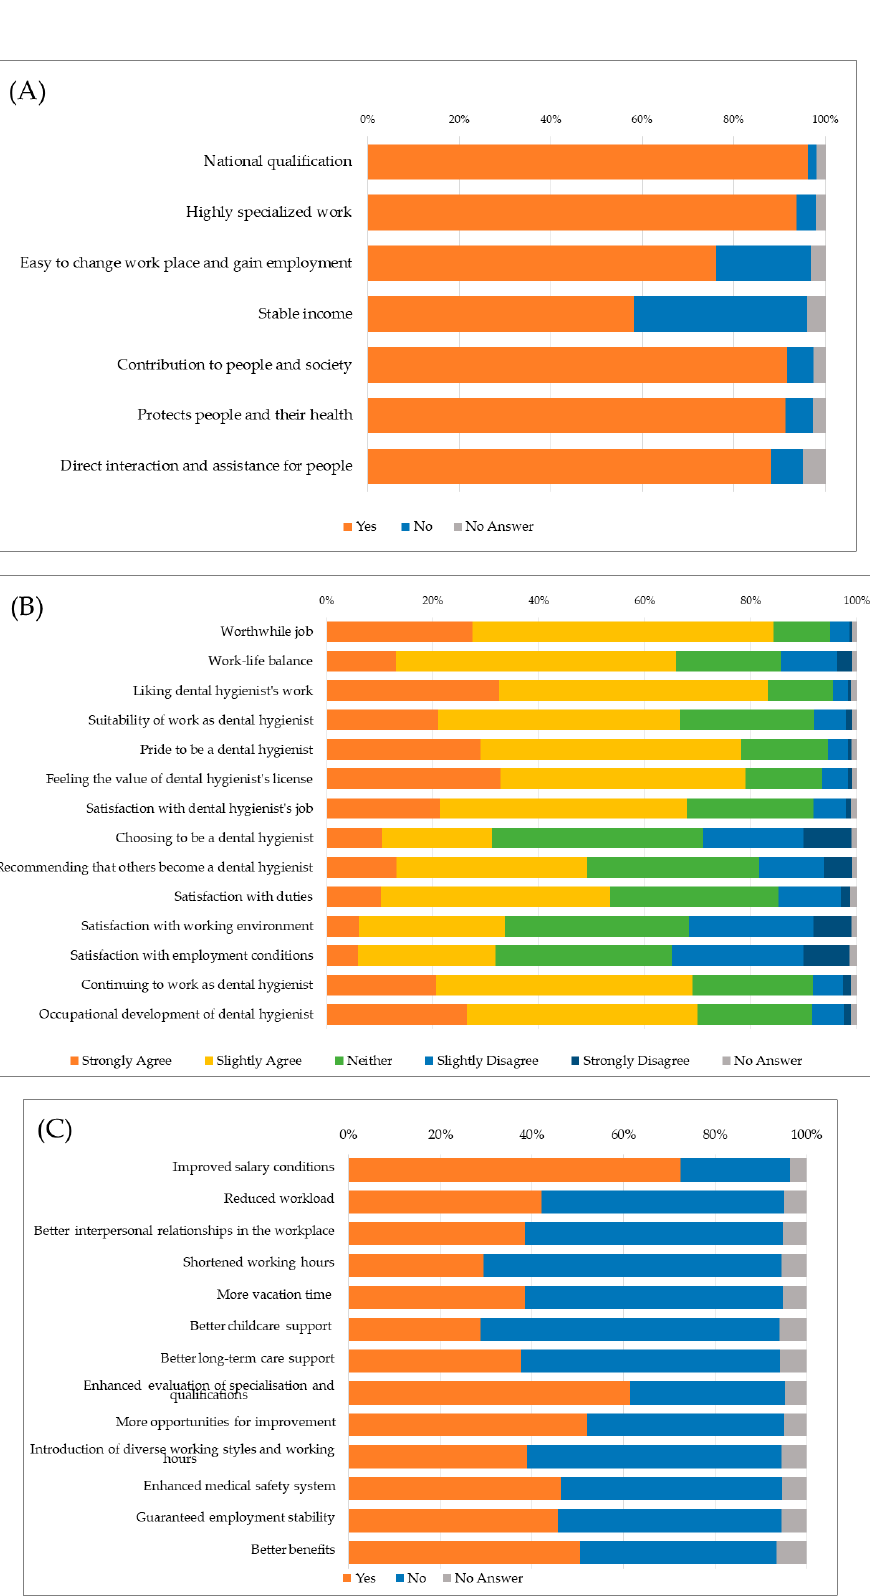
Figure 1. Simple tabulation of participants’ response to each questionnaire. Bar graphs shows the participant’s response to each questionnaire regarding job attractiveness ( A ), job satisfaction( B ), and the factors dental hygienists feel would improve the work environment ( C ).